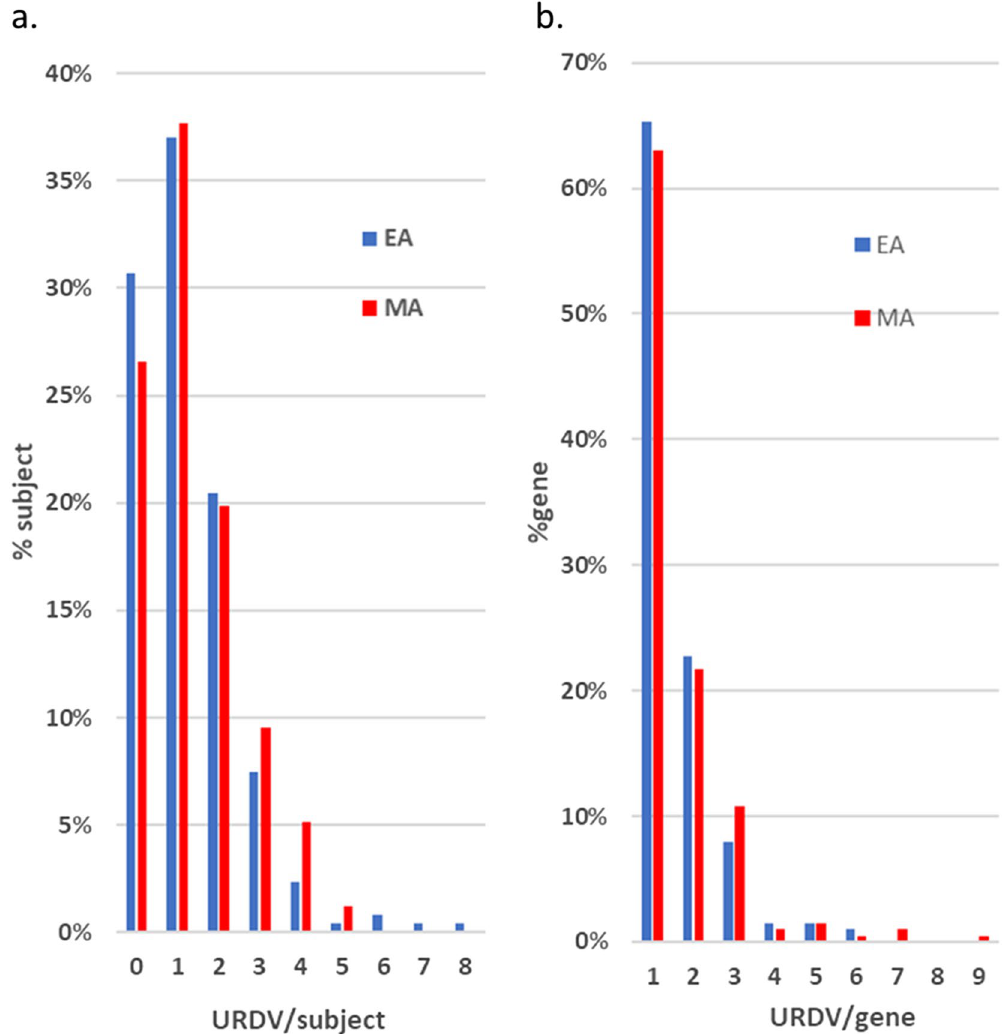
Figure 2. Distributions of URDVs Identified by WES. ( a ) Chart shows count of URDVs in NTD candidate gene(s) identified per exome of MM subjects varied from 0 to 8. In this study, the number of EA MMC subjects is 254 and the number of MA MMC subjects is 252. Approximately 25–30% subjects had no URDVs in NTD candidate genes, around 35% had one URDV, and the remaining had more than one. ( b ) Shows counts of URDVs discovered per NTD candidate gene ranged from one to nine with nearly 65% genes containing only one. Total number of URDV-containing NTD candidate genes found in EA and MA MMC subjects are 202 and 203